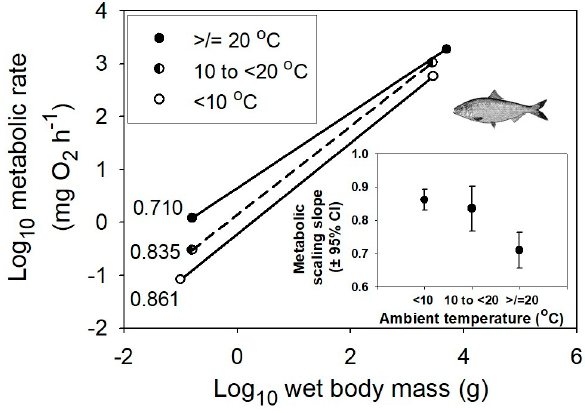
Figure 2. Ontogenetic scaling of metabolic rate in relation to body mass averaged for multiple species of marine teleost fishes at three different habitat temperature ranges, ≥ 20, 10 to <20, and <10 °C (data from [48]). The sample sizes ( n ) are 30, 19 and 40, respectively. The inset graph shows the negative relationship between the mean metabolic scaling slope (±95% confidence intervals) and habitat temperature. The fish picture is from [55].